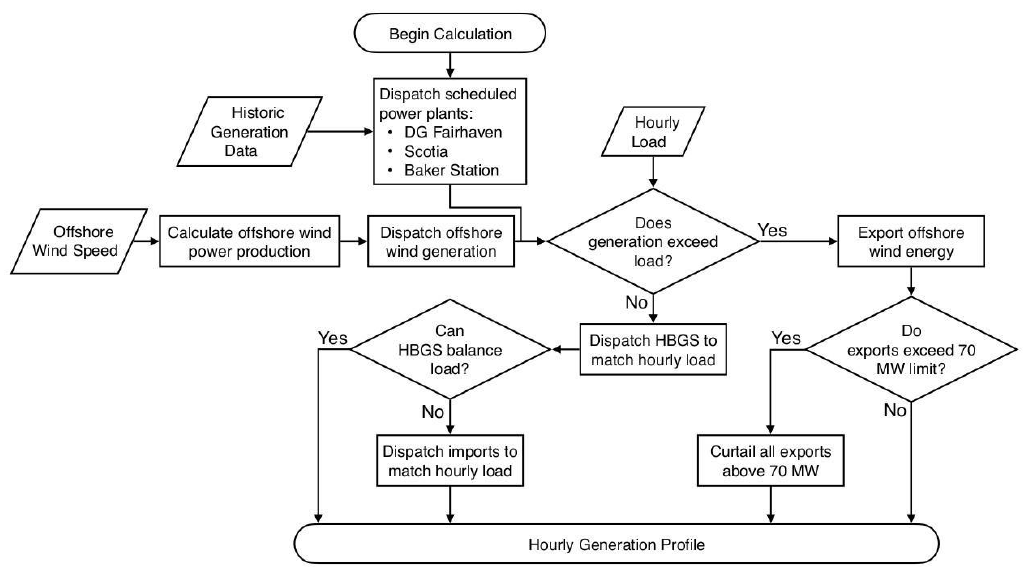
Figure 5. Algorithm for calculating hourly load and generation profile.